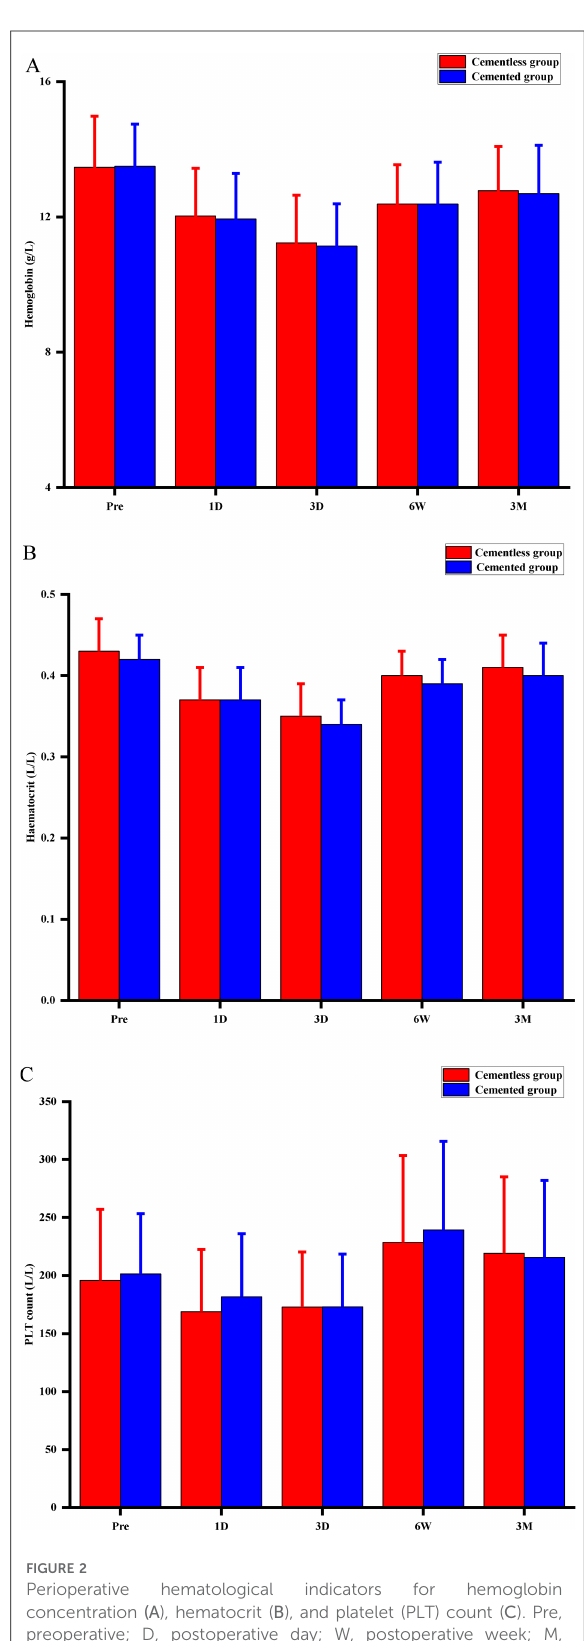
FIGURE 2 Perioperative hematological indicators for hemoglobin concentration (A ), hematocrit ( B ), and platelet (PLT) count ( C ). Pre, preoperative; D, postoperative day; W, postoperative week; M, postoperative month; P >0.05 at any time